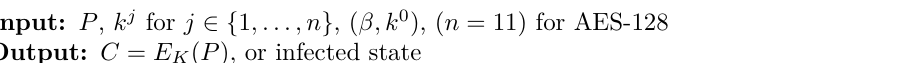
Algorithm 2 Infective countermeasure by Tupsamudre et al. (taken from